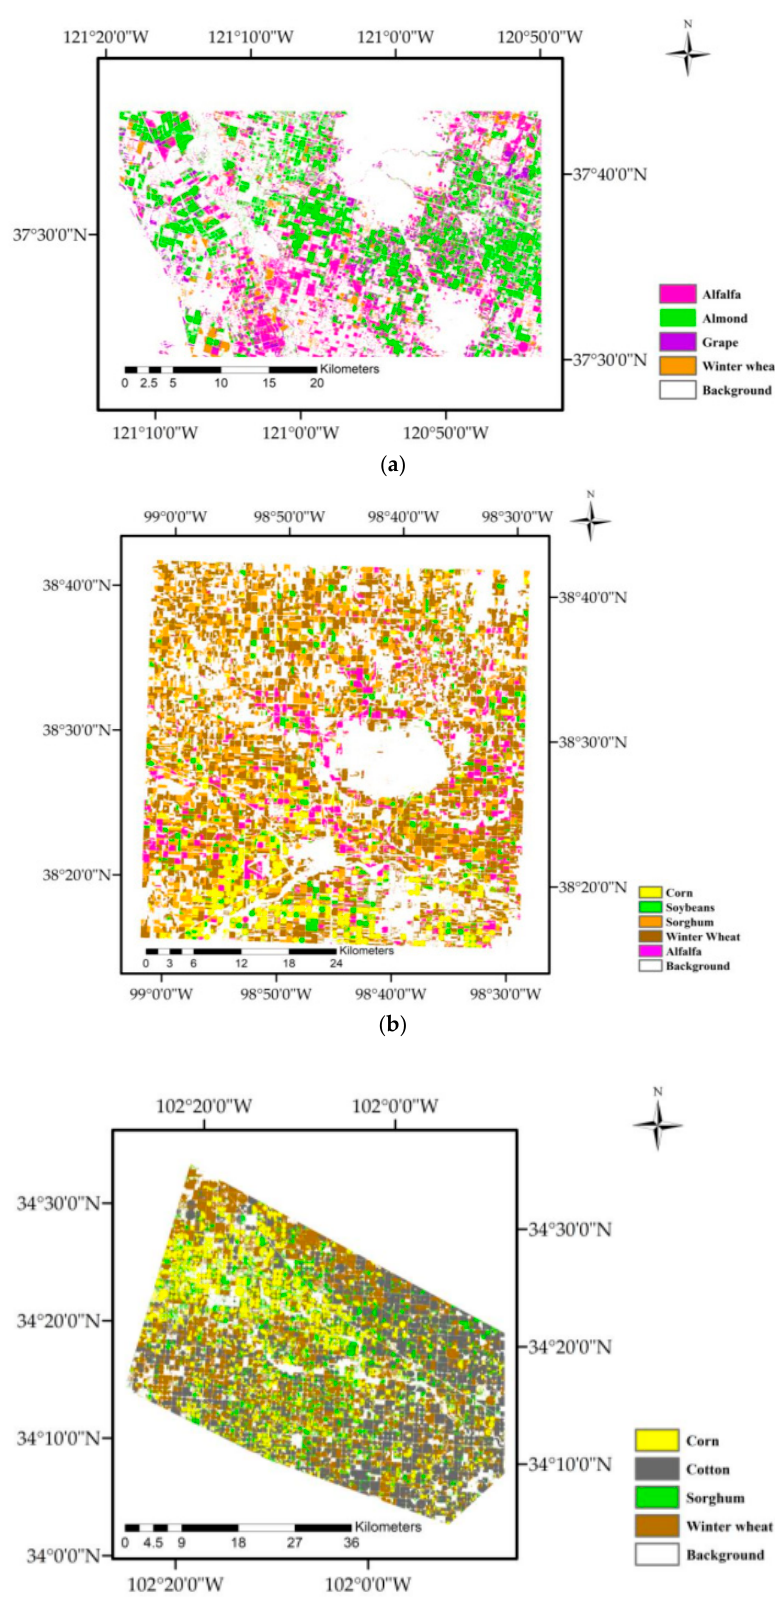
Figure 5. Crop classification maps obtained using NDVI + mLSTI long time series of: ( a ) study area 1, ( b ) study area 2, and ( c ) study area 3.